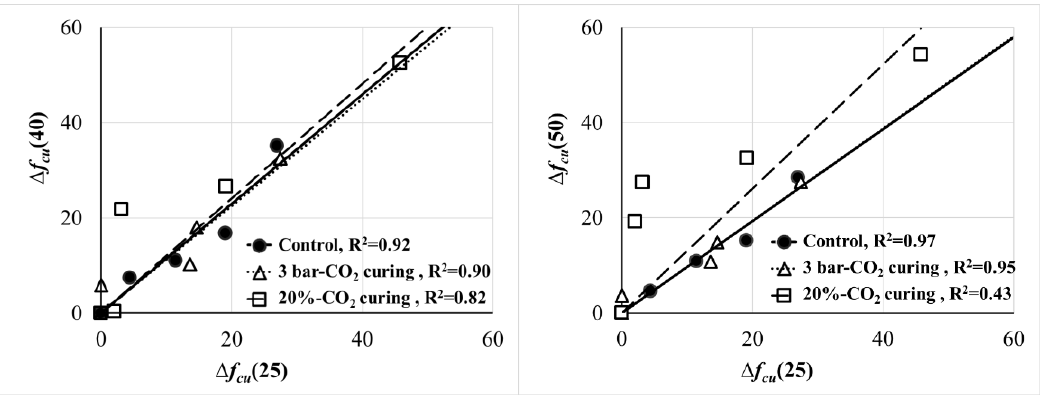
Figure 6. Comparison of the size effect on the strength development of mortar (W/C = 0.5).